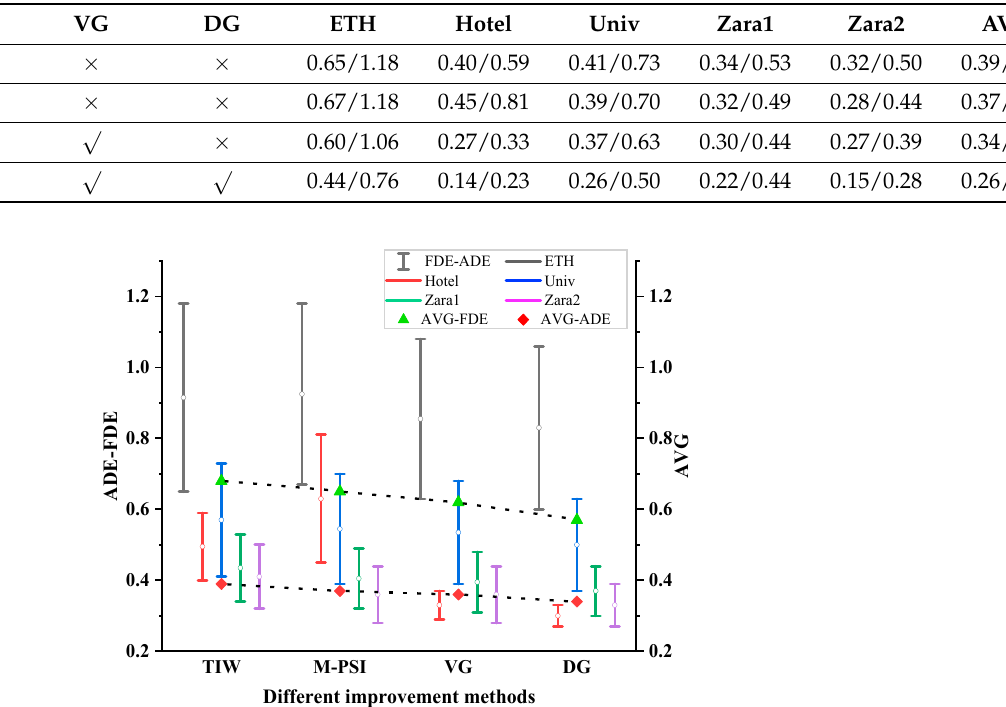
Table 3. The results of ADE/FDE obtained through ablation experiments.